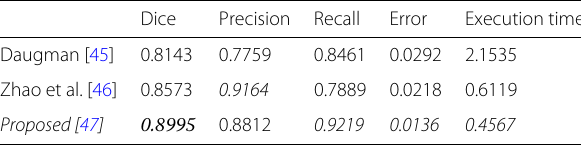
Table 5 Performance of our algorithm in the CASIA-Iris-Distance v4 compared to Daughman [45] and Zhao et al.